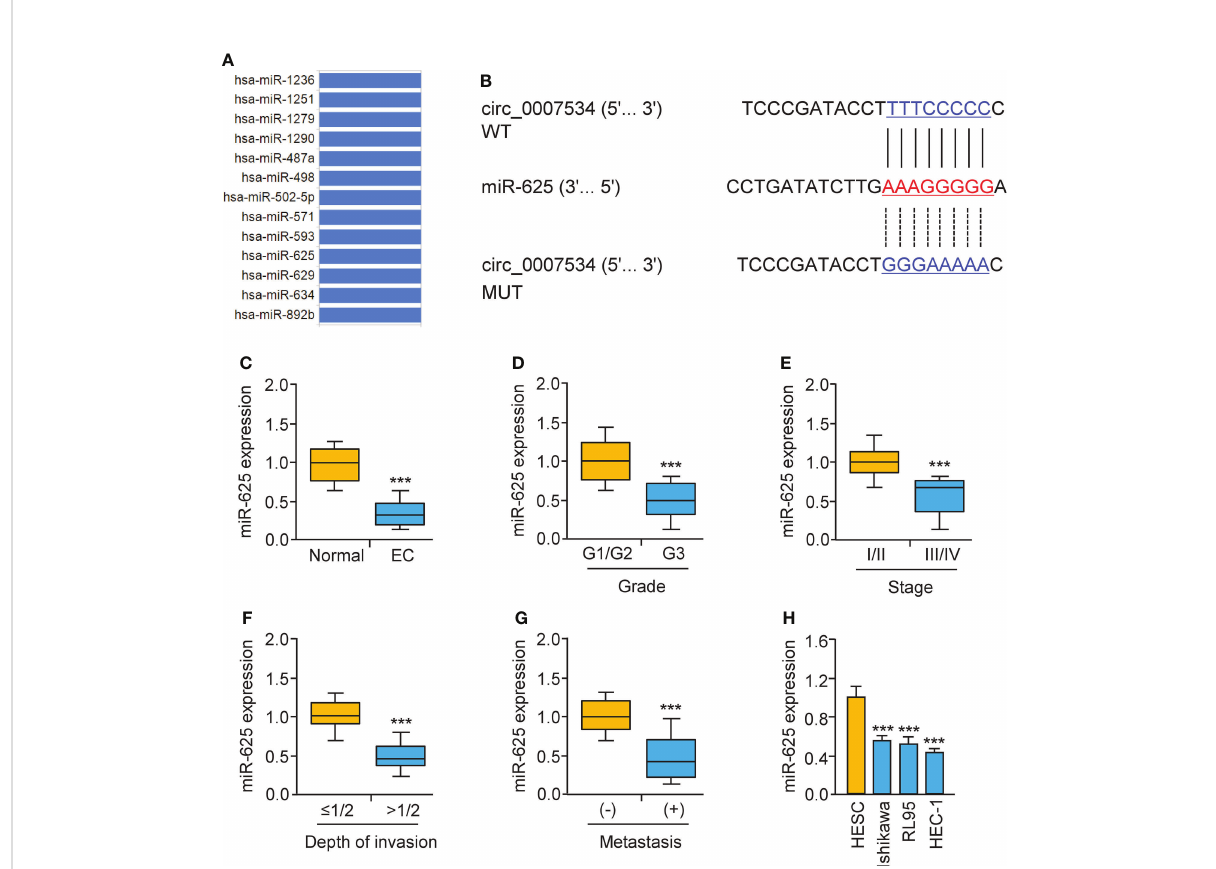
FIGURE 5 Low miR-625 levels are associated with the malignant progression of endometrial cancer. (A) The miRNAs that might bind to circ_0007534 were predicted using the CircInteractome database. (B) The luciferase reporter plasmids contained wild-type (WT) and mutated (MUT) miR-625 binding sites in the circ_0007534 sequence. (C) Real-time PCR detection of miR-625 expression in endometrial cancer and normal tissues. (D-G) MiR-625 expression in endometrial cancer patients with different tumor grades (D) , tumor stage (E) , depth of invasion (F) , and the presence (or absence) of lymph node metastasis (G) were explored using qRT-PCRs. (H) MiR-625 expression in endometrial cancer cells and normal cells. *** P <